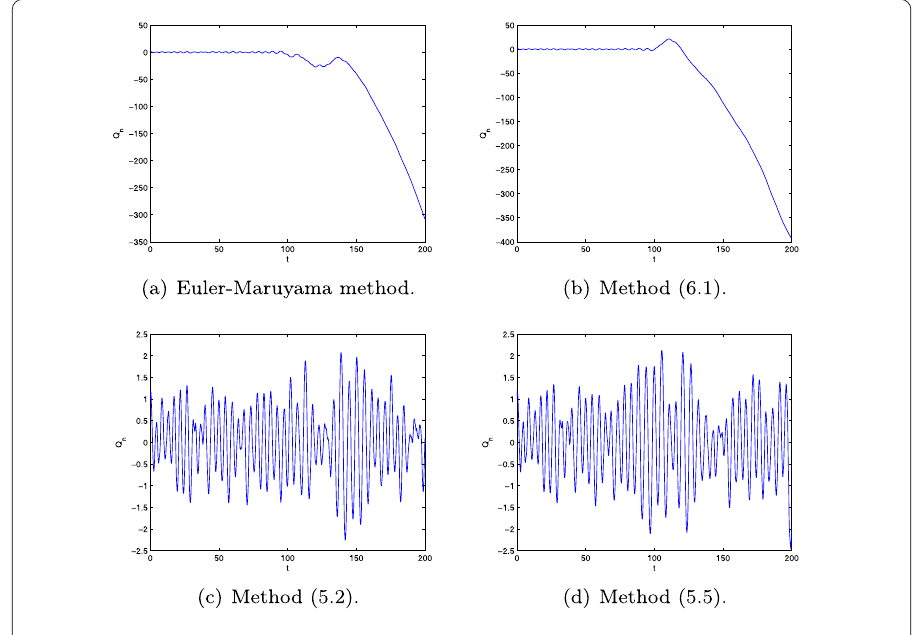
Figure 5 Simulation of a sample trajectory of Eq.